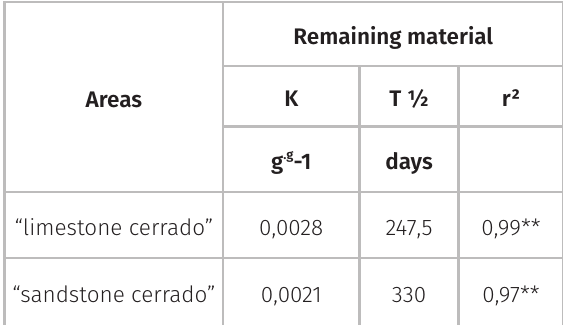
Table I. Constant decomposition rate ( k ), half-life (T ½) and coefficient of determination (r²) of the relationship analysis between leaves of the “limestone cerrado” and “sandstone